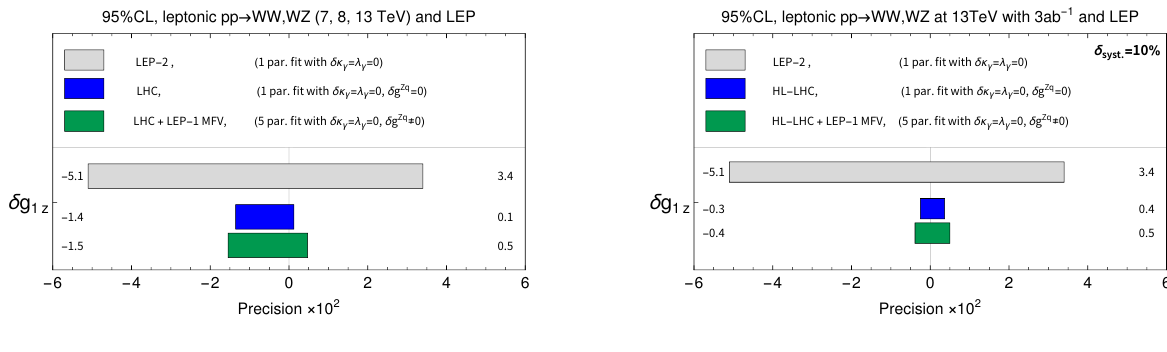
Figure 11 . Current ( left ) and future ( right ) 95% CL constraints on (cid:14)g 1 z . In gray, LEP-2 results. In blue, constraint from LHC diboson data alone. In green, (cid:12)t to LHC diboson data including the anomalous V (cid:22) qq vertices and pro(cid:12)ling over them with the LEP-1 MFV constraints. In the projection of the HL-LHC bounds, a 10% systematic uncertainty in the channel pp ! WW; WZ is